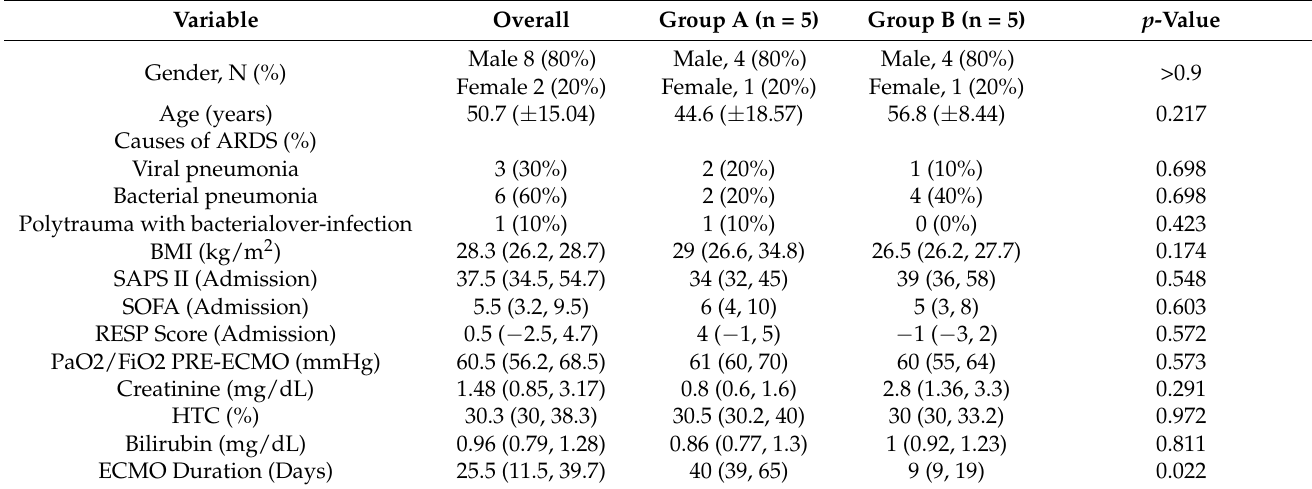
Table 1. Patients’ anthropometric and clinical characteristics according to ECMO duration